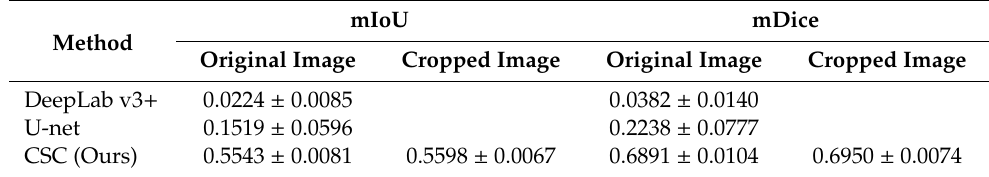
Table 2. Evaluation of segmentation results obtained using existing methods (DeepLab v3 + and U-net) and CSC (Cropping-Segmentation-Calibration) with respect to the mIoU and mean Dice coe ffi cient